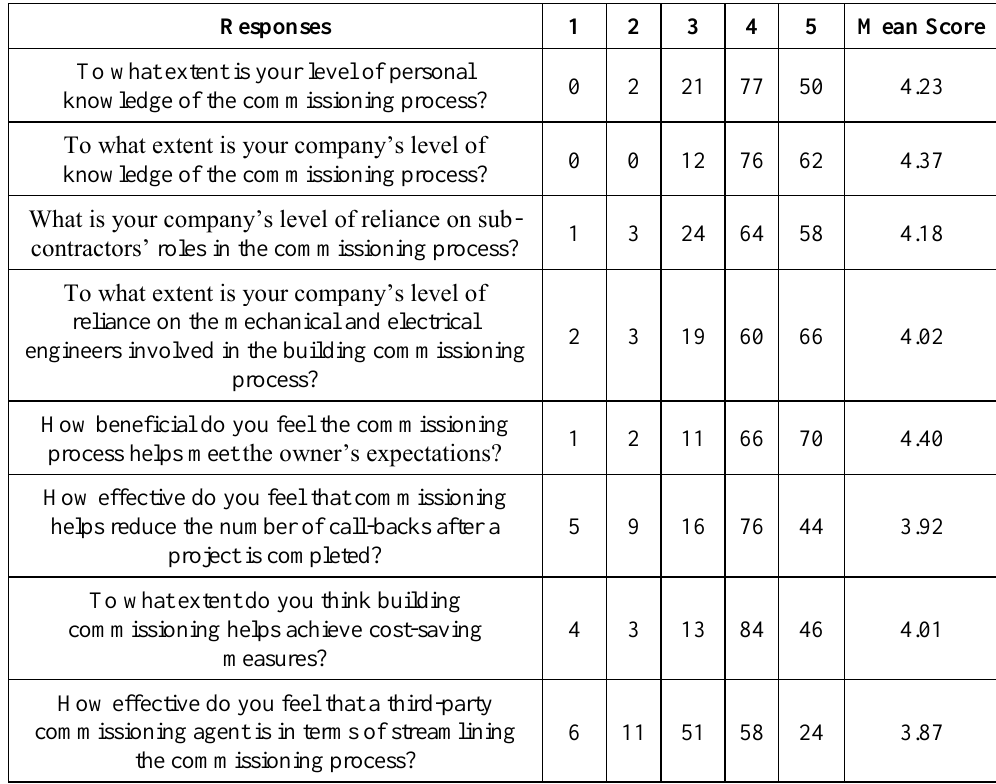
Table 4. Level of Awareness and Adoption of Building Commissioning Practices (developed by the